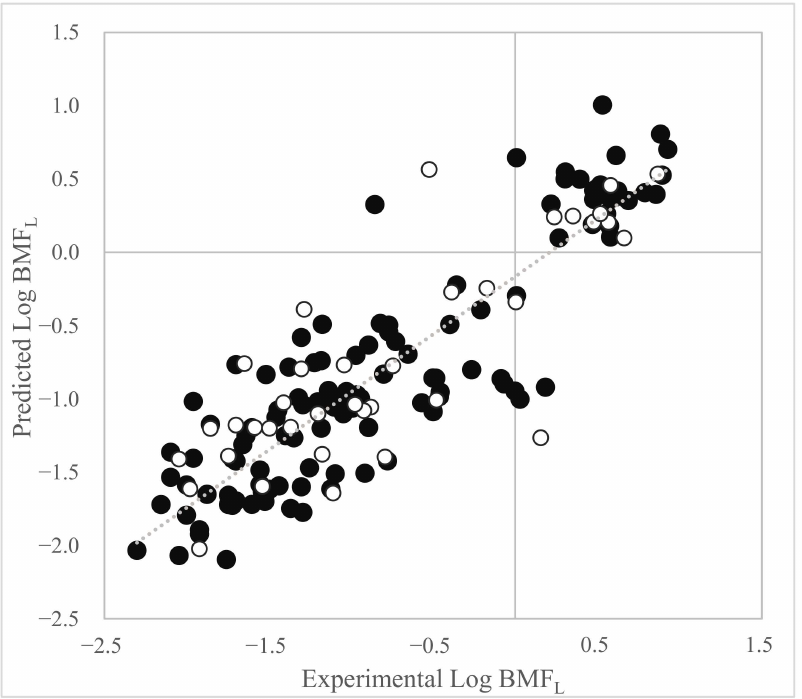
Figure 1. Plot of experimental vs. predicted Log BMF L values (calculated by Equation (1)). Black dots = training set. White dots = prediction